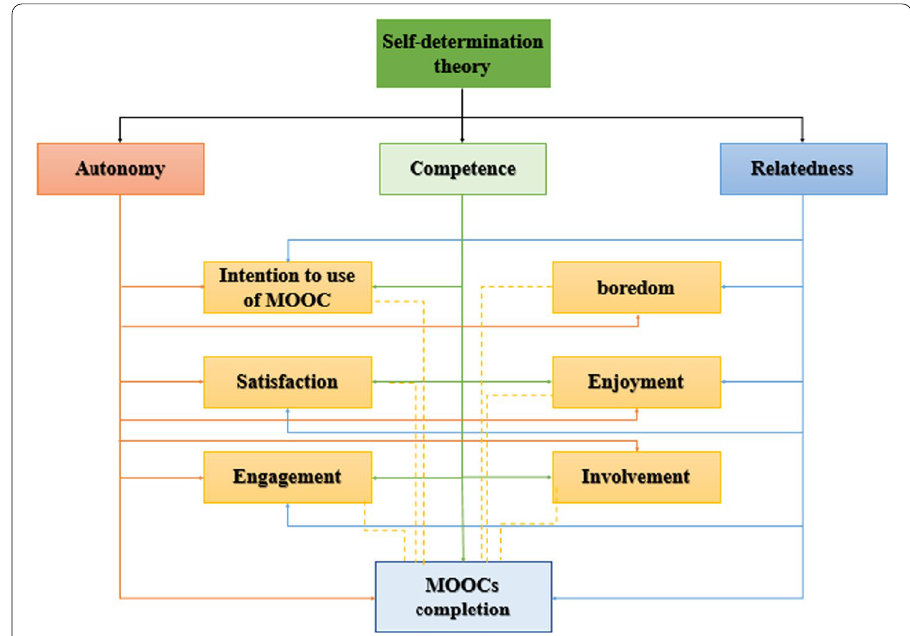
Fig. 3 Overview of SDT role in relation to MOOCs completion